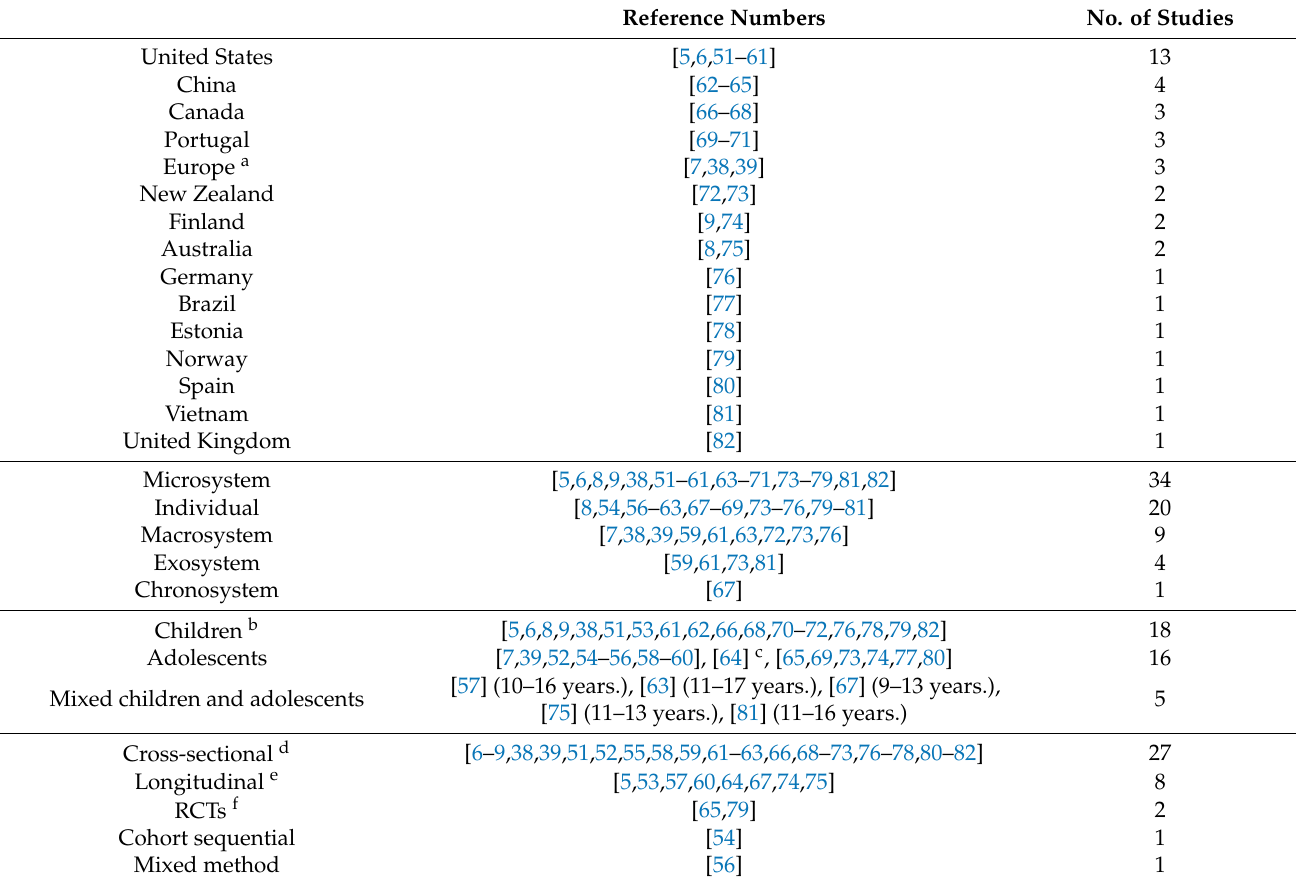
Table 2. Frequencies of countries, ecological systems, age groups, and study designs across the selected studies reviewed ( N =